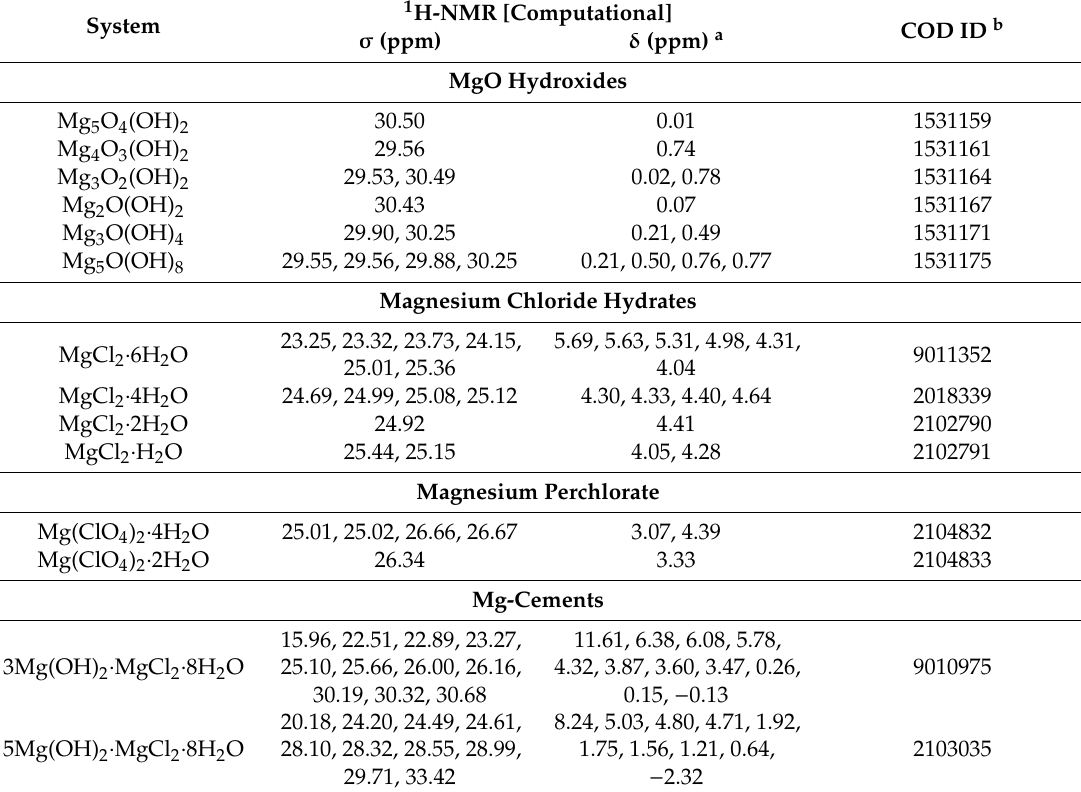
Table 2. Computational 1 H-NMR chemical shieldings ( σ ) and chemical shifts ( δ ) for 17 Mg-O-H, Mg-Cl-O-H, and Na-O-H containing